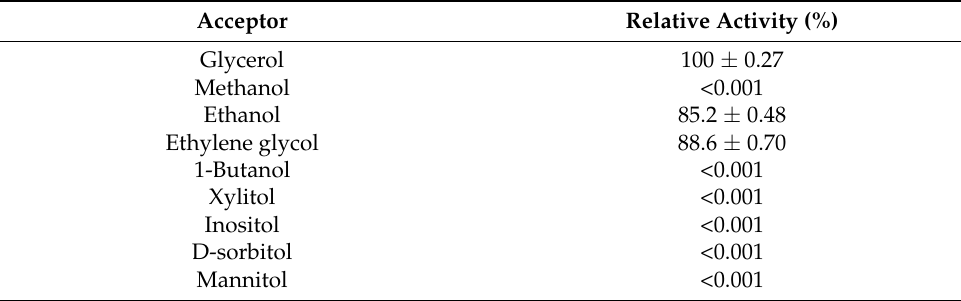
Table 4. Acceptor specificity of α -galactosidase.